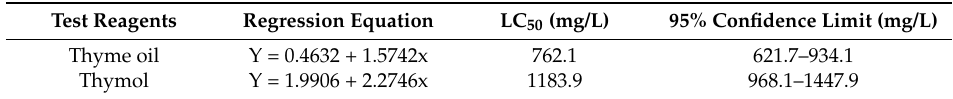
Table 2. Toxicity regression lines of thyme oil and thymol based on mortality after 24 h of treatment. Test